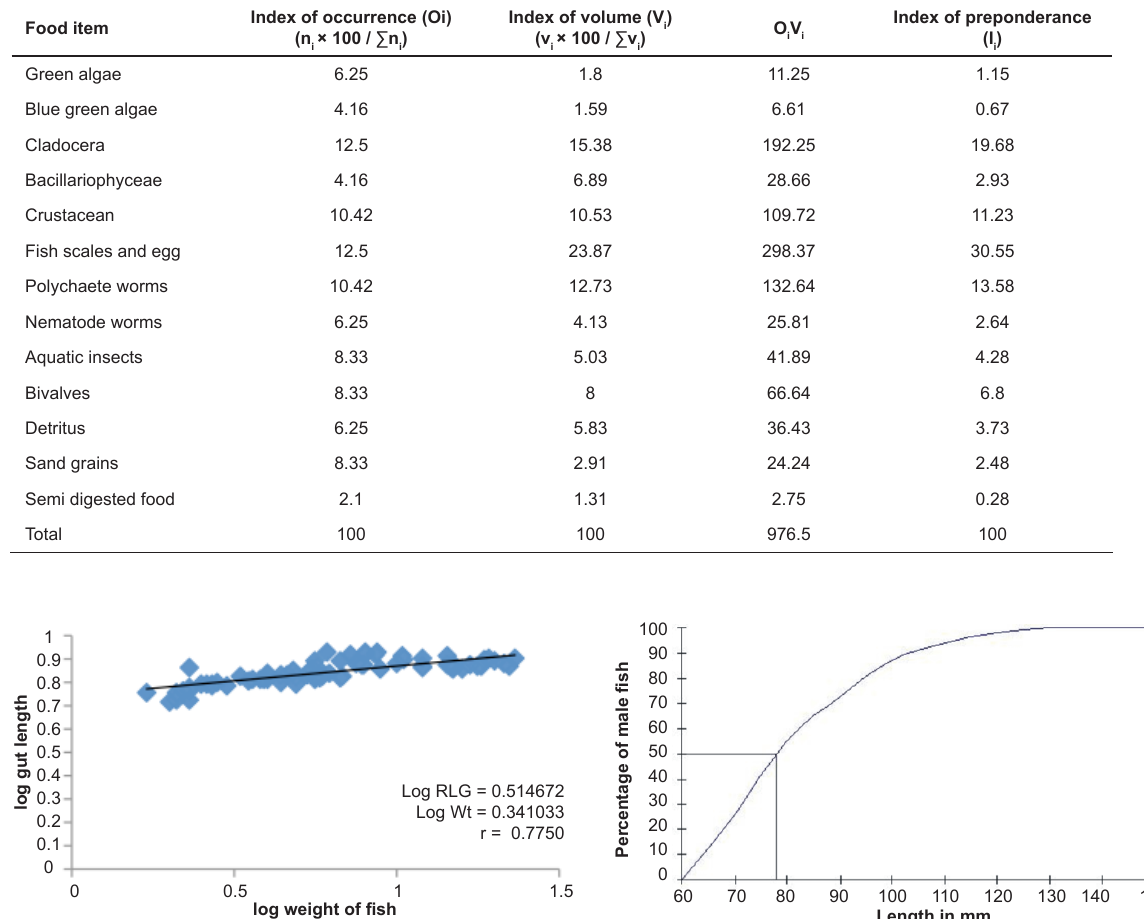
Table 1. Index of preponderance of Stenogobius gymnopomus